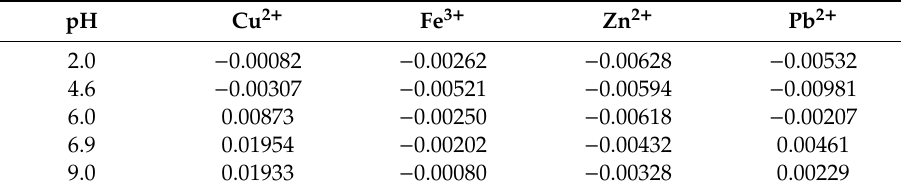
Table 5. Values of e ff ective charge density after conversion to surface charge density σ .